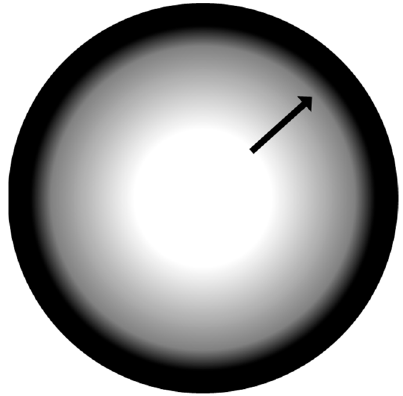
Figure 4. Representative sphere formation scheme; the arrow indicates the direction of contraction of the part still soft towards the solid outer shell.